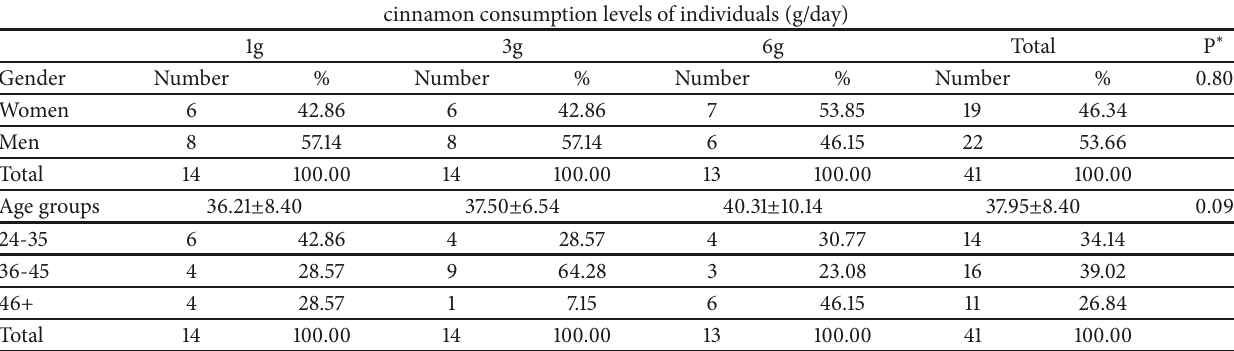
Table 1: Distribution of the cinnamon-consuming individuals by gender and age groups.